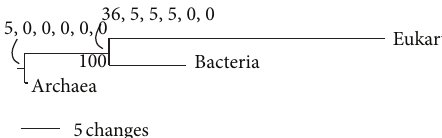
Figure 11: One of three optimal phylogenetic tree reconstructions with identical topologies recovered from an exhaustive maximum parsimonysearch(58steps;CI=1;RI=1;HI=0;RC=1; 𝑔 1 = − 0.707) of the abundance of viral replicon types of dsDNA, ssDNA, dsRNA, ssRNA(+), ssRNA( − ), and retrotranscribing viruses. Abundance was scored on a 0–20 scale and ranged from 0 to 759 viral replicons. Vectors of abundance reconstructions in internal nodes are given as percentage of total abundance of replicons in superkingdoms. Boostrap support values are shown below